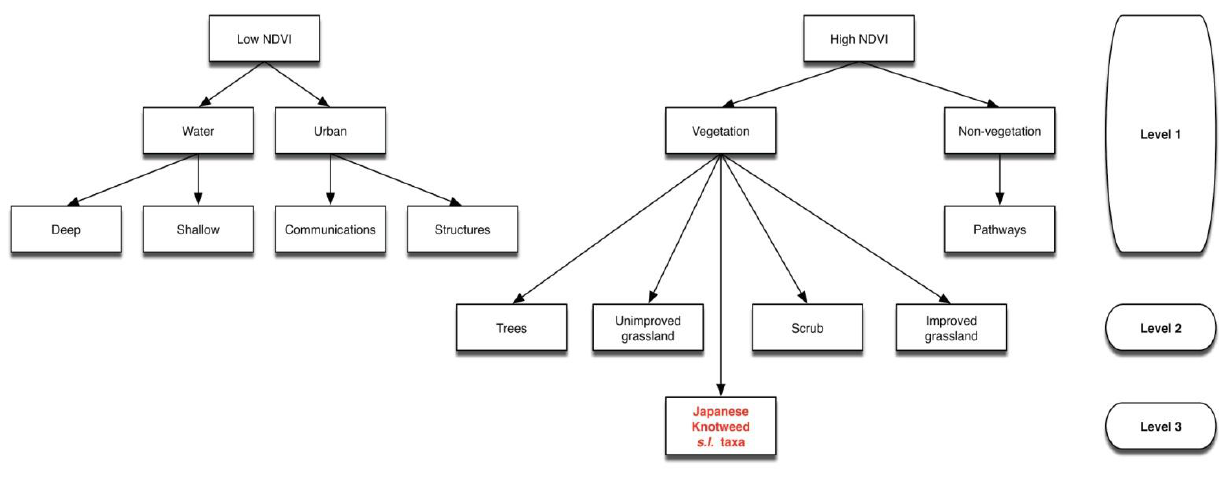
Figure 1. Semantic structure of the current analysis showing hierarchical relationships between segmentation Levels (Levels 1 to